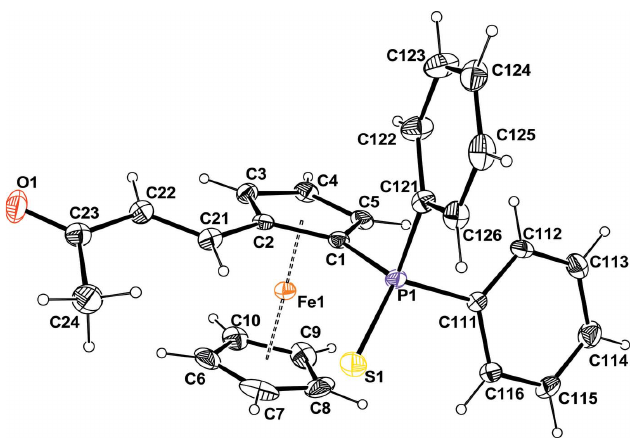
Figure 1 Molecular structure of the title compound with the atom-labeling scheme. Ellipsoids are drawn at the 50% probability level and the H atoms are represented as small circle of arbitrary radii.